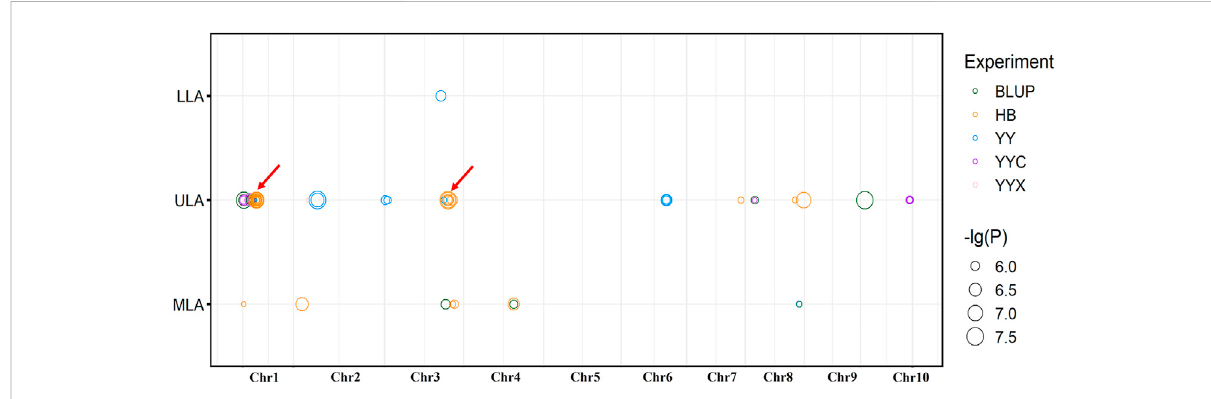
FIGURE 2 Distribution of signi fi cant loci detected by GWAS on maize chromosomes. Red arrows indicate co-located QTLs, for the same trait in different